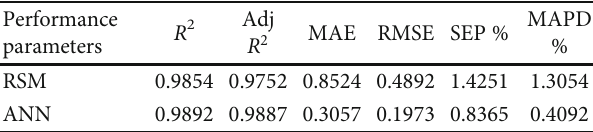
Table 4: Evaluated results of RSM and ANN